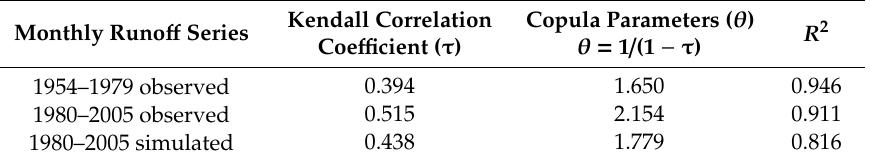
Figure 7. Recurrence period of joint distribution of drought severity and drought duration. ( a ) The risk of natural period, ( b ) for the human activities period, and ( c ) for the simulated human activities. Table 1. Copula function parameters. R 2 —coefficient of determination.